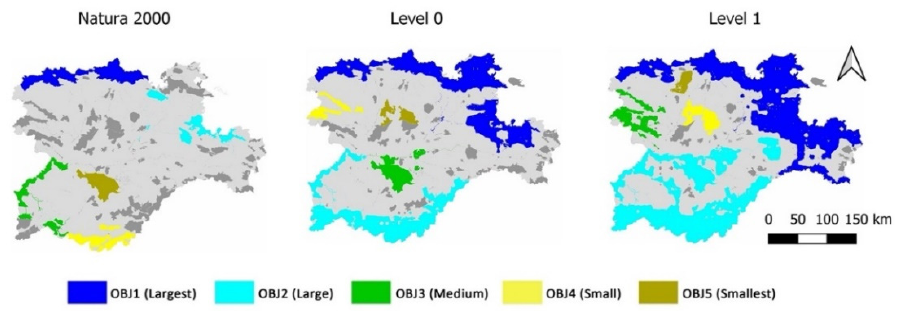
Figure 3. The five largest network objects in the three scenarios. Table 1 shows the status summary providing network information on: